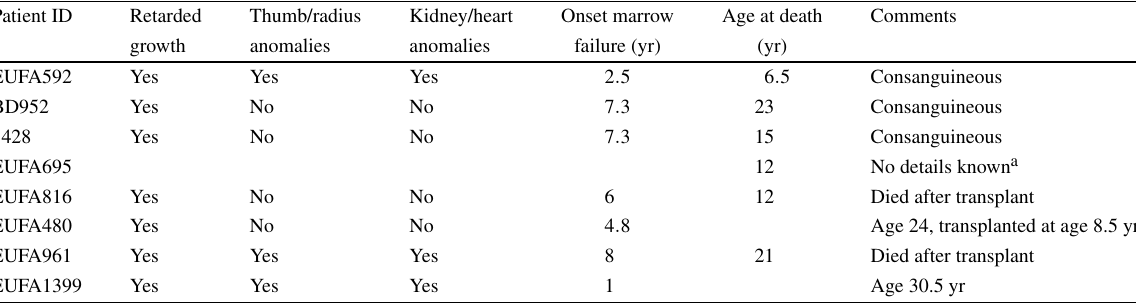
Clinical features of the FA-I individuals